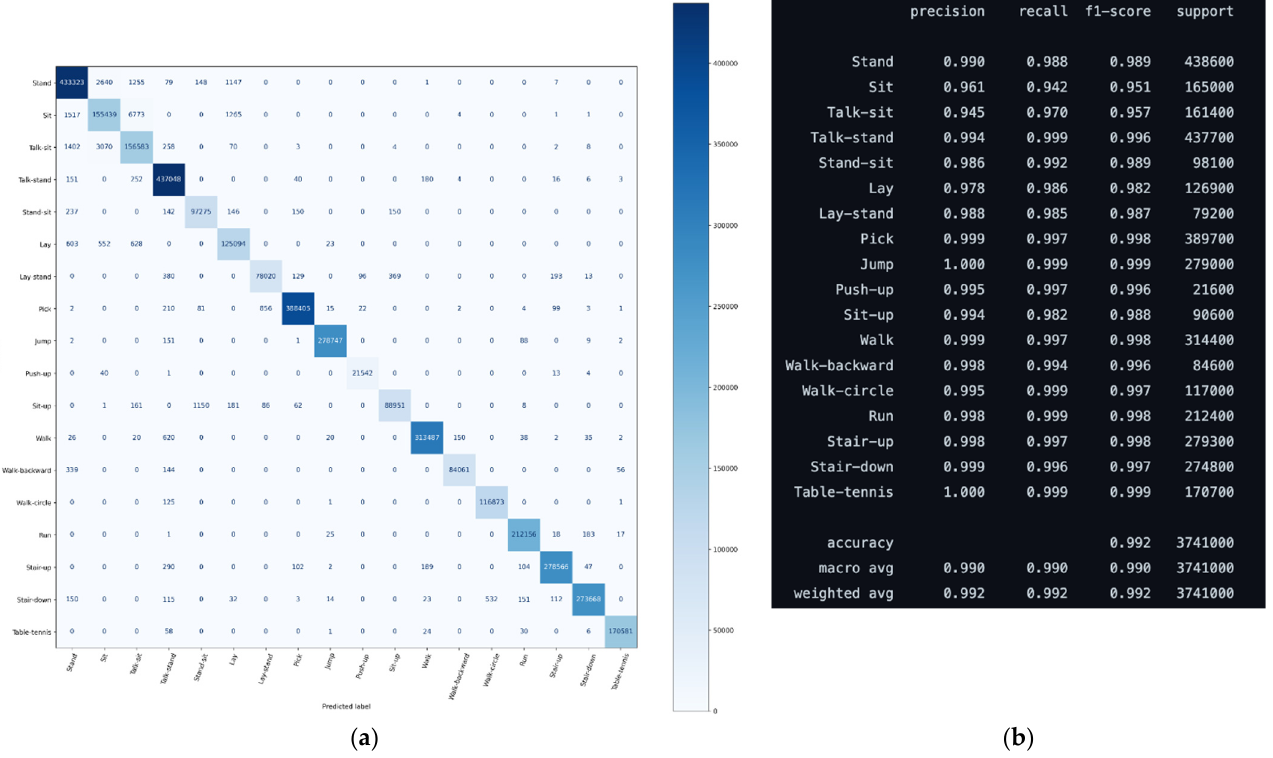
Figure 9. ( a ) Confusion matrix; ( b ) class-wise performance of the transformer model for human activity recognition.